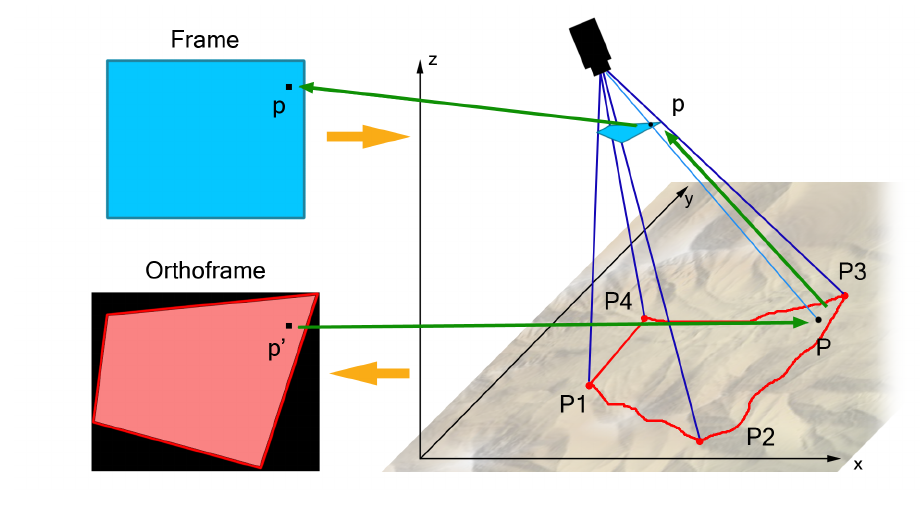
Figure 4. Orthorectification: value of each pixel p (cid:48) is determined through a backtracking process to find the corresponding pixel p in the original